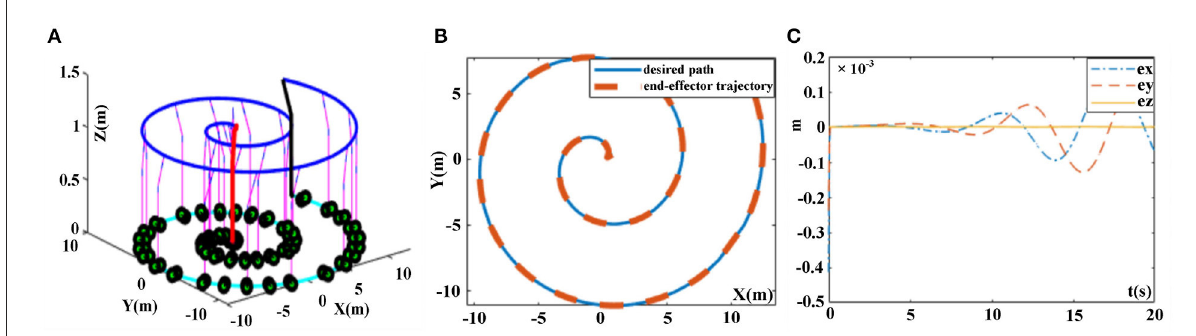
FIGURE17 Trajectory tracking results synthesized by the FTCRNN-based model (41) in noisy environment. (A) Whole tracking motion trajectories. (B) Desired path and actual trajectory. (C) Tracking errors.